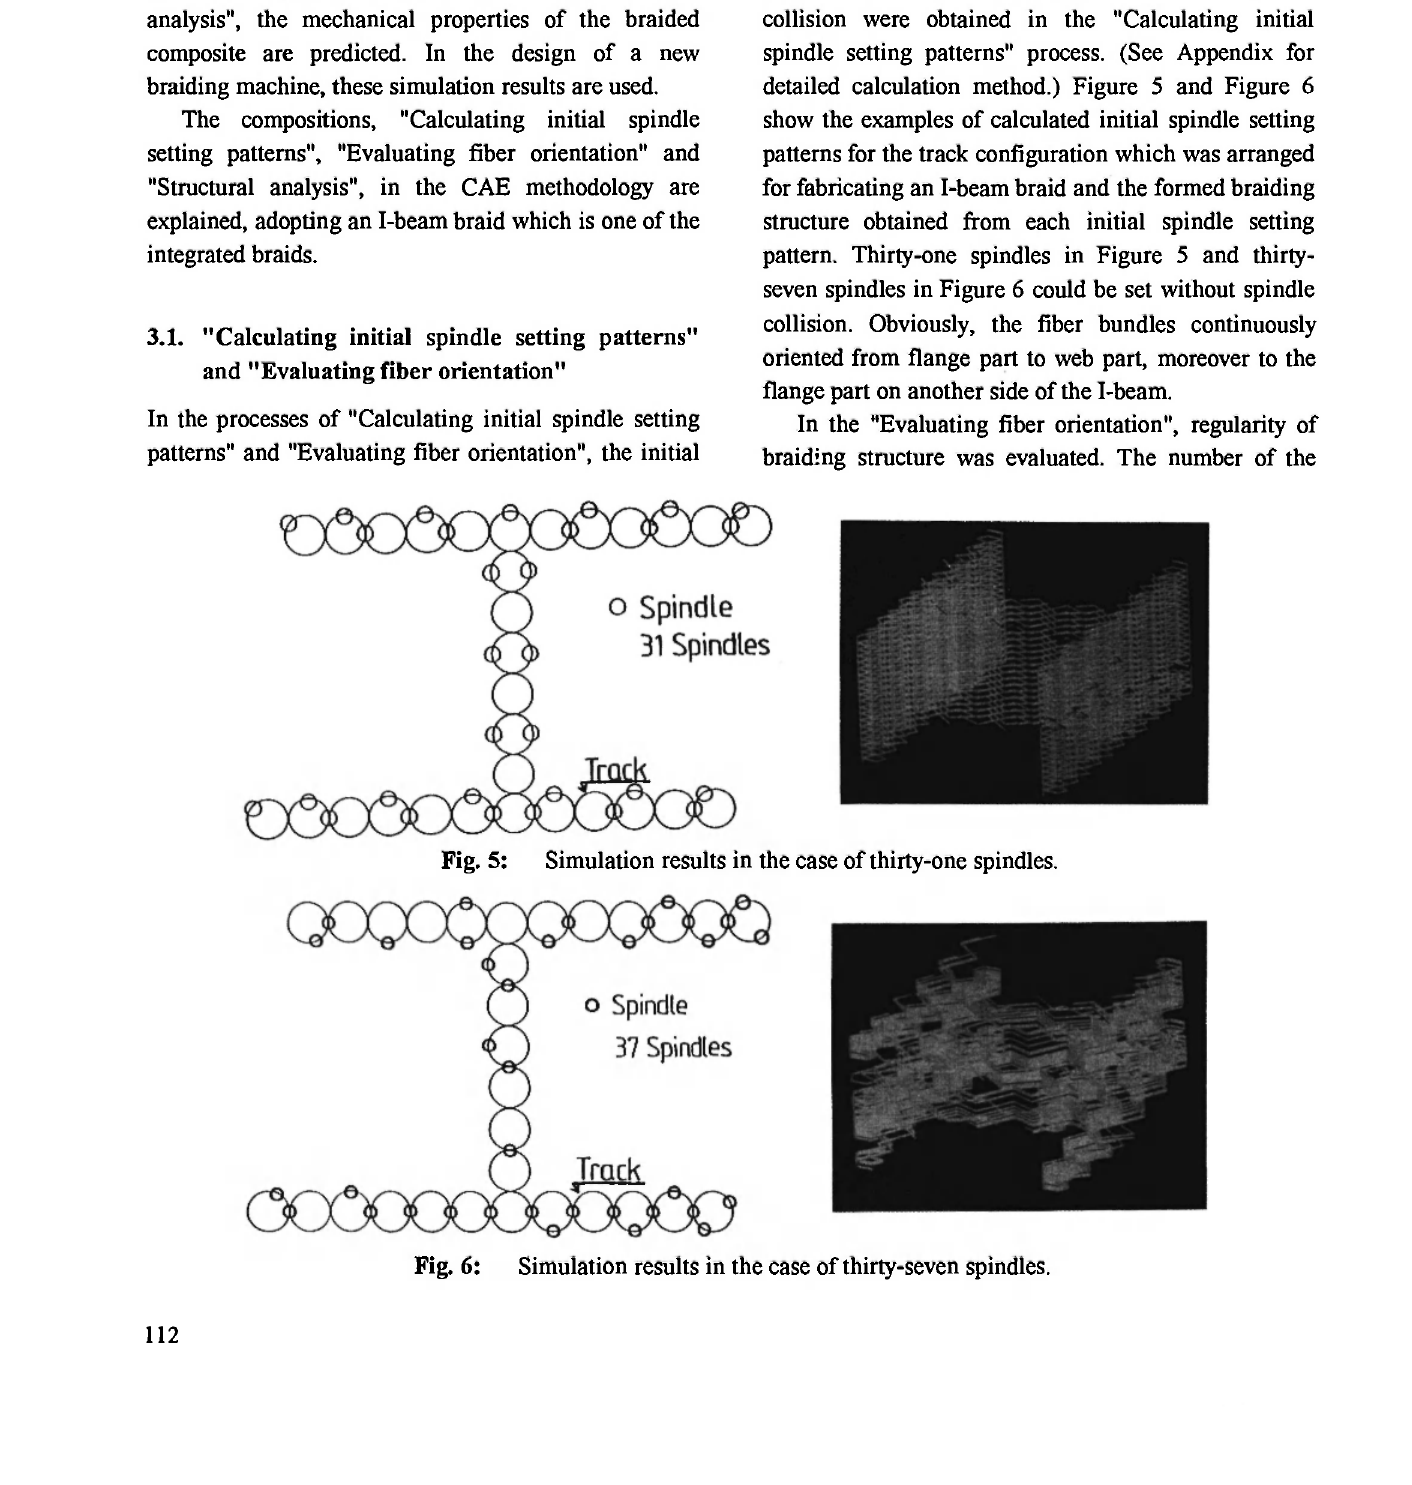
Fig. 6: Simulation results in the case of thirty-seven